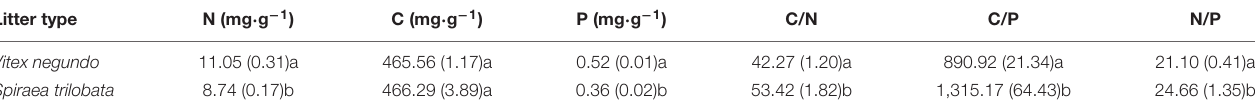
TABLE 2 | Initial chemical properties of the leaf litter. Litter